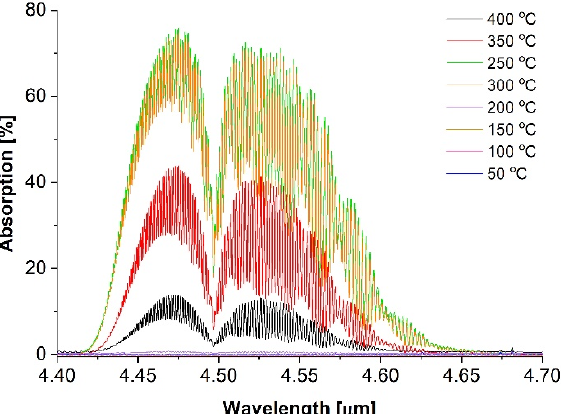
Figure 3. Exemplary N 2 O absorption spectra observed in the vapors obtained from a 2 mg PrNQ sample at a temperature of 50 to 400 °C. The measurement was carried out at the following condi- tions: resolution 0.5 cm − 1 , 2.4 m gas cell, 660 mbar, beam splitter KBr, and liquid nitrogen cooled MCT detector.